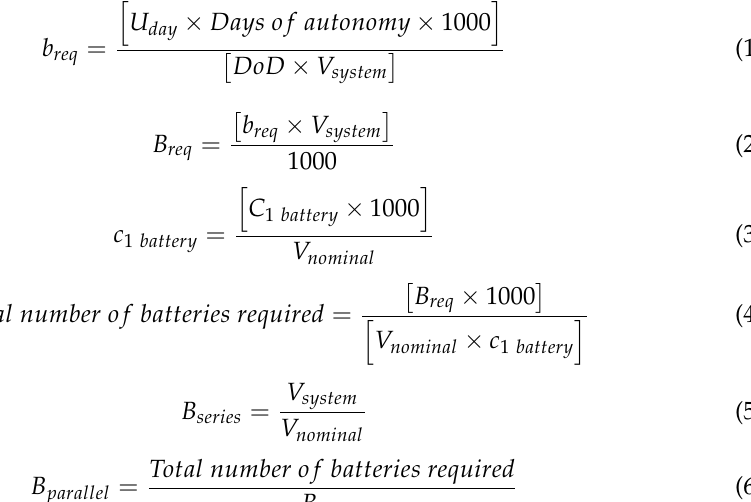
Table 4. Specifications of the battery considered for the analysis [source- PVsyst 7.2 database] .